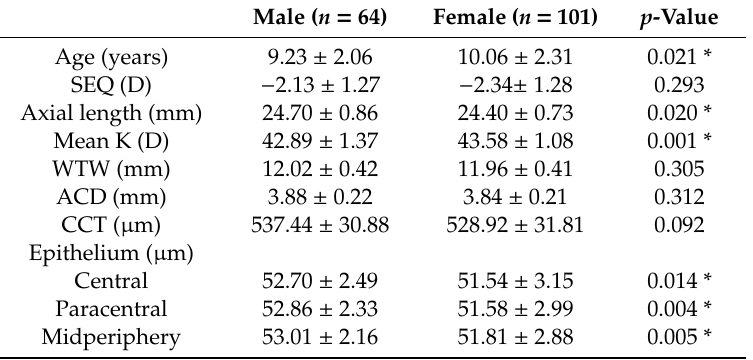
Table 2. Gender di ff erences in the ocular and body measurements of Korean children ( n = 165). Male ( n =